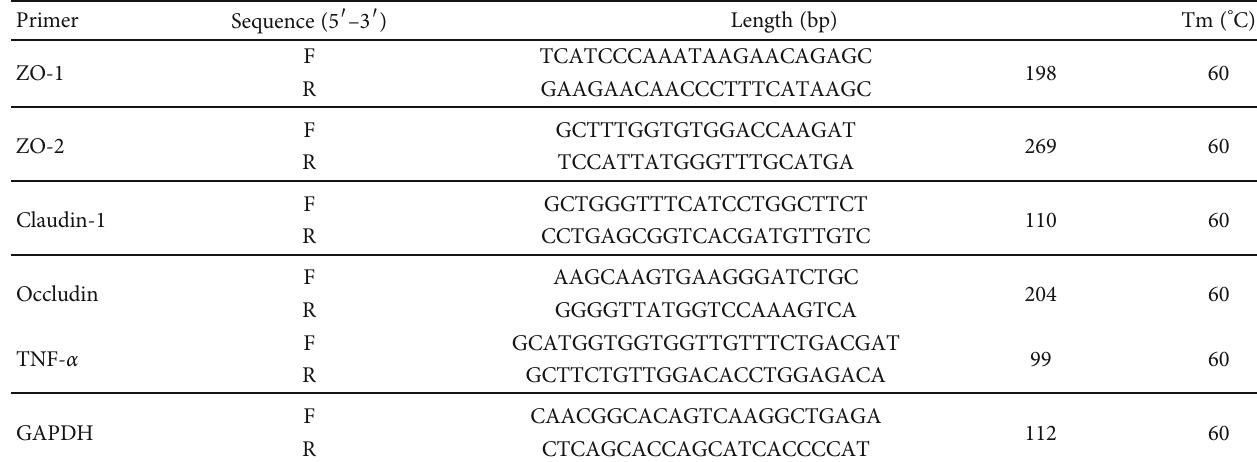
Table 1: Speci fi c primers used for real-time